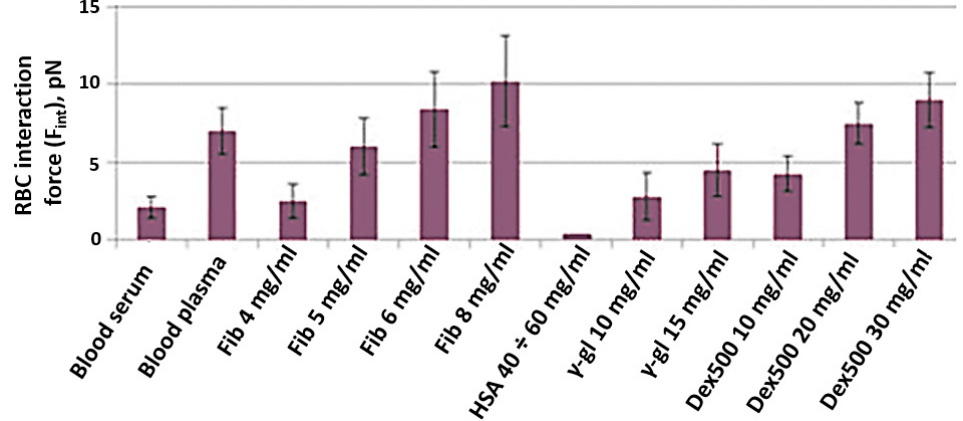
Figure 6. RBC interaction force (F int ), measured in vitro with laser tweezers in different media— autologous blood serum; autologous blood plasma and model PBS solution of different macro- molecules at various concentrations: Fib, fibrinogen (data was taken from our previous publica- tion [24] for better representation and convenience for the reader); HSA, human serum albumin; γ -gl, gamma-globulin from human serum; Dex500, dextran 500 kDa. Blood was from a healthy male individual. Measurements were performed on N = 10 pairs of RBCs in each sample. Diagrams show the mean values; error bars designate the mean square deviations, including the laser tweezer calibration error.